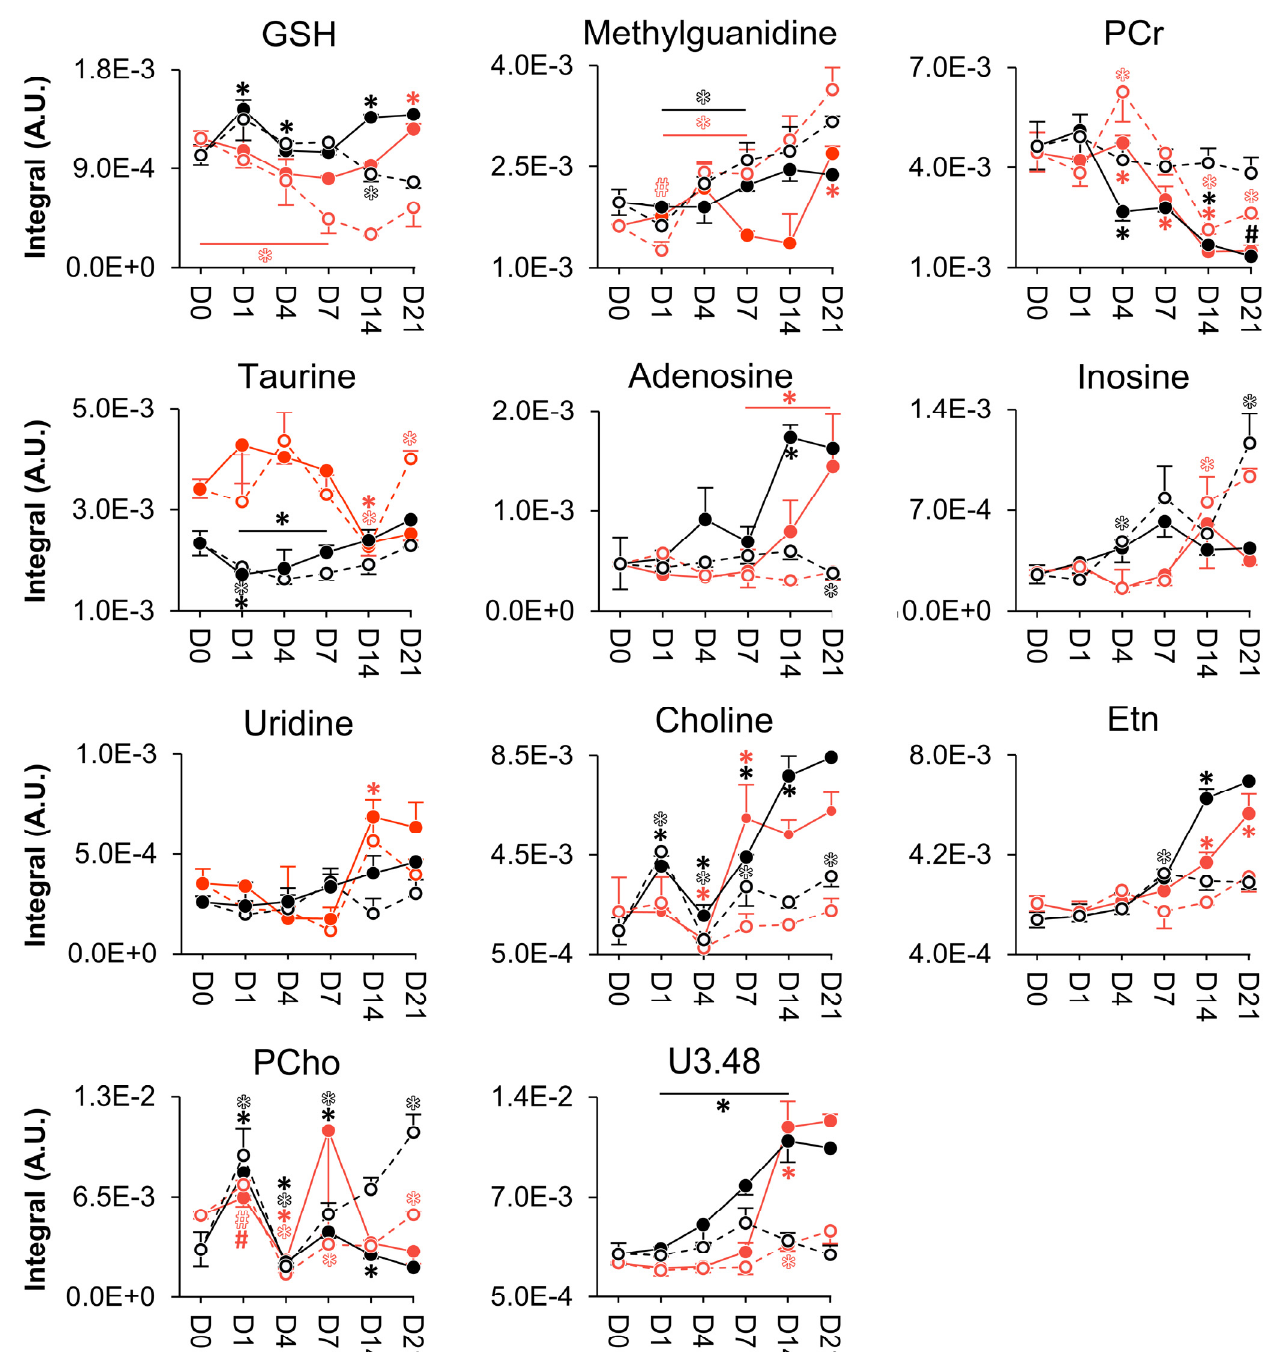
Figure 6. Donor-independent metabolic variations specific to hAMSCs osteodifferentiation (solid lines) in comparison with their control counterparts (dashed lines). Line graphs are defined as described in the caption of Figure 3. Di, day i; GSH, glutathione (reduced); PCr, phosphocreatine; Etn, ethanolamine; PCho, phosphocholine; U δ , unassigned signal at chemical shift δ . *, Wilcoxon Rank-sum test p- value < 0.05 compared to the previous timepoint (shown only in cases where spectral confirmation was observed); #, relevant variations compared to the previous timepoint exclusively based on visual inspection (applicable when n < 3 samples, i.e., day 0 from donor 1 and osteogenic day 21 from donor 2). All symbols are represented in the same colour as the corresponding line, with open and filled symbols for proliferating and differentiating cells, respectively.